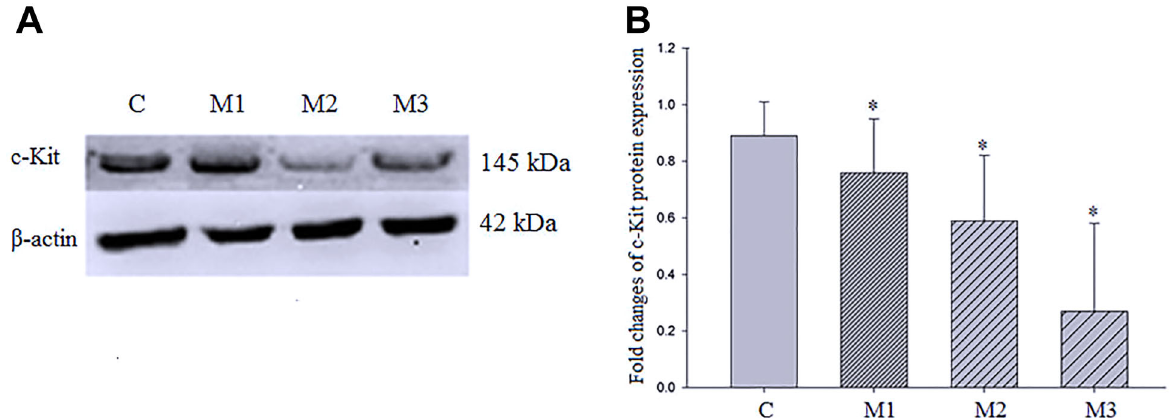
Figure 2. A , Western blotting detection of c-Kit protein expression of interstitial cells of Cajal after intestinal obstruction. Intestinal tissues were from rats with sham-operation (C), one day obstruction (M1), two days obstruction (M2), and three days obstruction (M3). B , Histogram of relative c-Kit protein expression. Results are reported as means ± SD. *P o 0.05 among the 4 groups (one-way ANOVA followed by Newman-Keuls